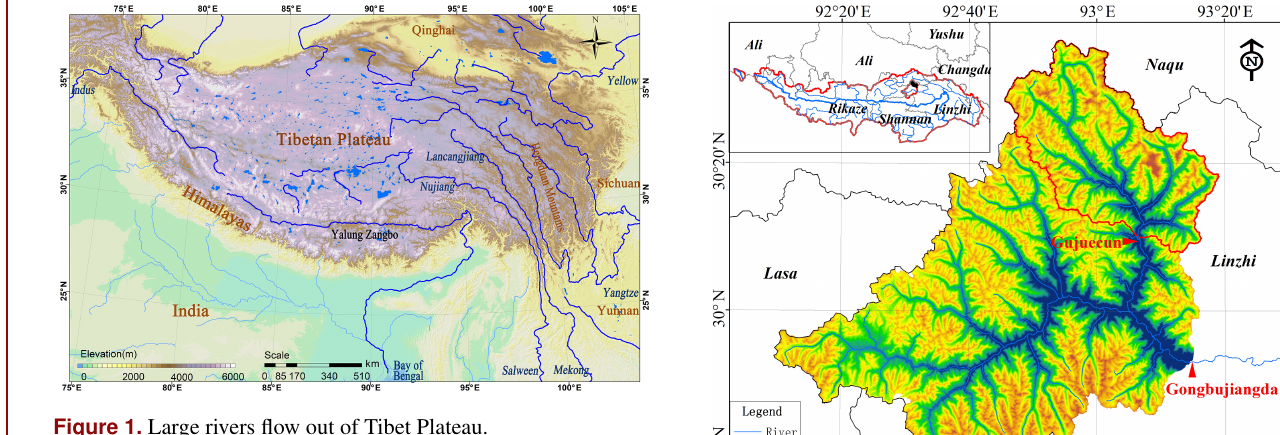
Figure 1. Large rivers flow out of Tibet Plateau.